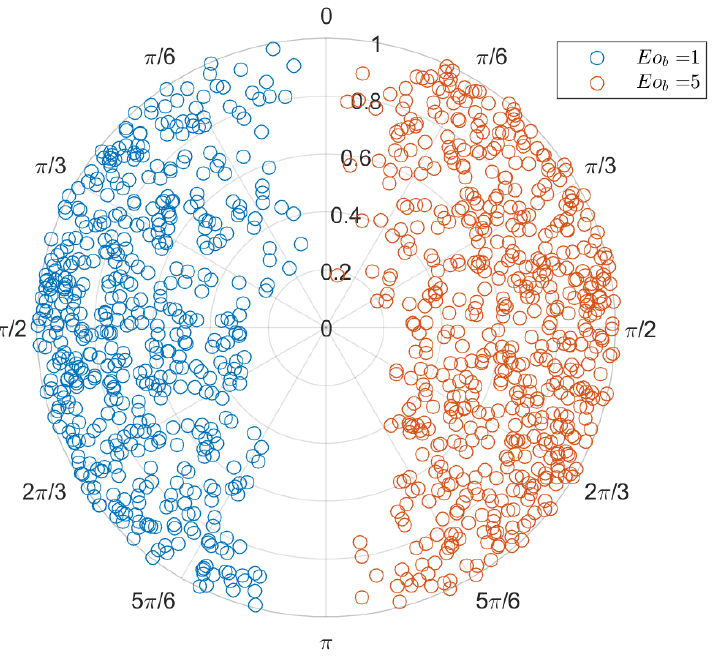
Figure 11. The location of drops with respect to bubble centers. The drops at several times are shown in the left frame for Eo b = 1.0 (blue circles on the left) and Eo b = 5.0 (red circles on the right).